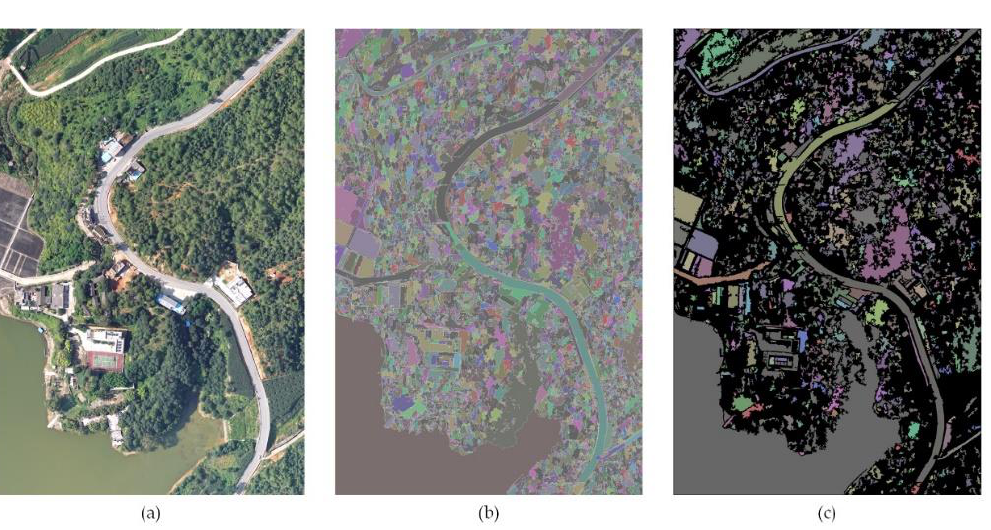
Figure 8. ( a ) Original map; ( b ) segmentation results of the method by Gaetano et al. [ 22 ]; ( c ) segmentation results of our proposed